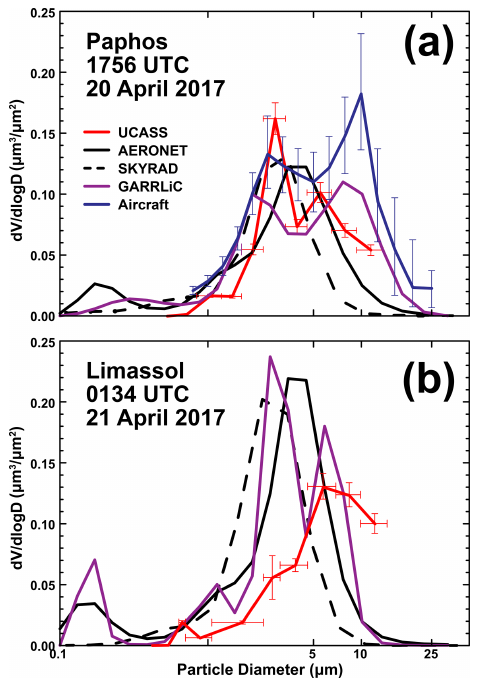
Figure 7. Total-column volume–size distribution from the UCASS (red), AERONET (black solid), SKYRAD (black dashed), GAR- RLiC (purple), and aircraft (blue, only in a ) obtained during (a) the first launch on 20 April 2017 and (b) the second launch on 21 April 2017. For clarity, only error bars of the UCASS and CAPS measure- ments are shown. Details on the locations and measurement times are provided in Table